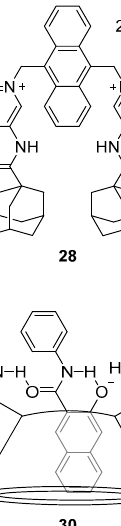
system demonstrated high selectivity for Hg 2+ over a variety of cations. Binding of Hg 2+ led to absorption profile changes along with a blue shift in fluorescence emission from 577 to 509 nm and quenching of emission intensity, with a low detection limit of 1 pM. The fluorescence quenching effect was attributed to the disruption of excited-state intramolecular proton transfer (ESIPT). The original fluorescence shown by 30 is due to photoinduced tautomerism of the naphthamide from its enol form ground state to the keto form excited state by proton transfer and subsequent radiative decay to afford fluorescence emission. As Hg 2+ is coordinated to 30 through the phenoxide oxygen and amide NH of the naphthamide, ESIPT is disrupted and fluorescence quenching occurs. Environmental applications of the sensor 30 were also demonstrated with doped Hg 2+ in real world water samples.